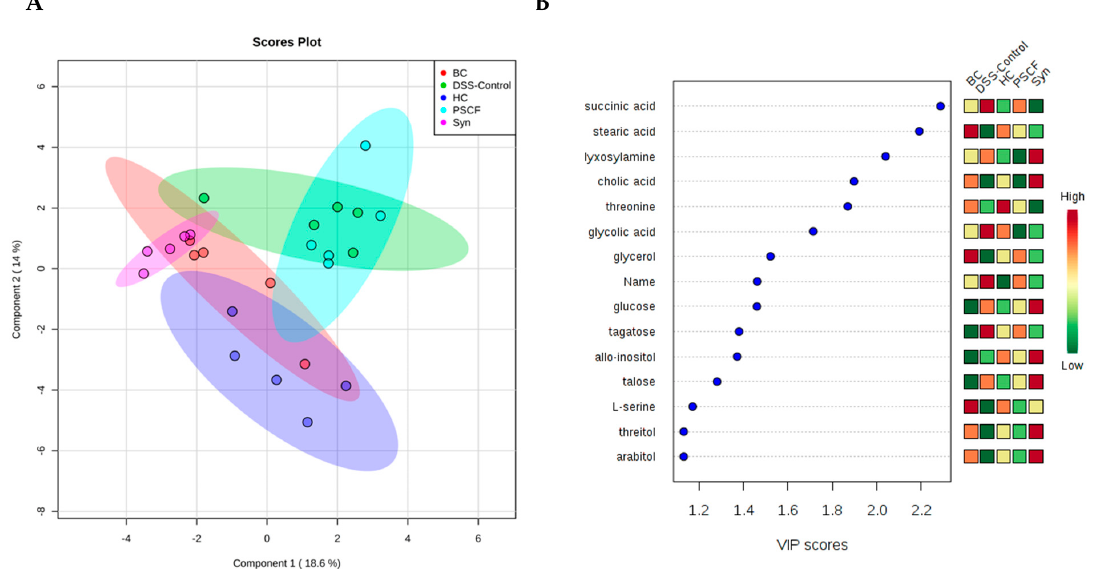
Figure 6. Effect of B. coagulans spores, PSCF and synbiotic on metabolic modulations in DSS-induced colitic mice. ( A ) 2D-PLS-DA plot showing spatial division among groups that received different supplementations, DSS-control mice that received no supplementation and HC. ( B ) Key compounds separating the groups based on variable importance projection (VIP) score plot in PLS-DA analysis. (BC- B. coagulans , Syn-synbiotic).